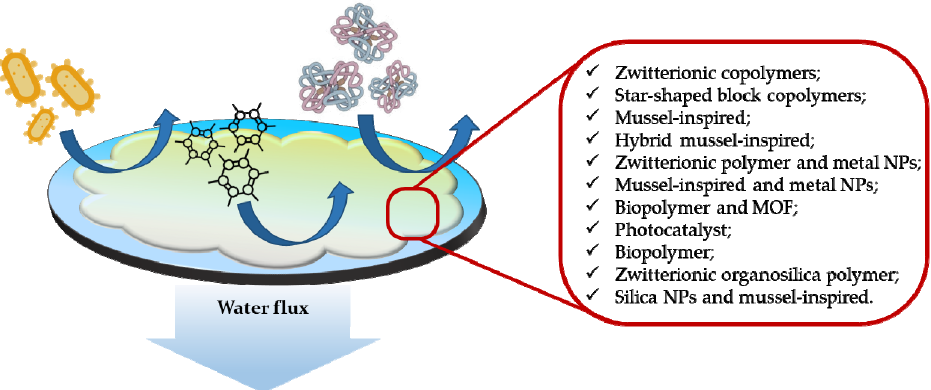
Figure 4. Representation of a general antifouling coated membrane for common water foulants (bacteria, proteins, other organic compounds) and some antifouling functional agents [81].